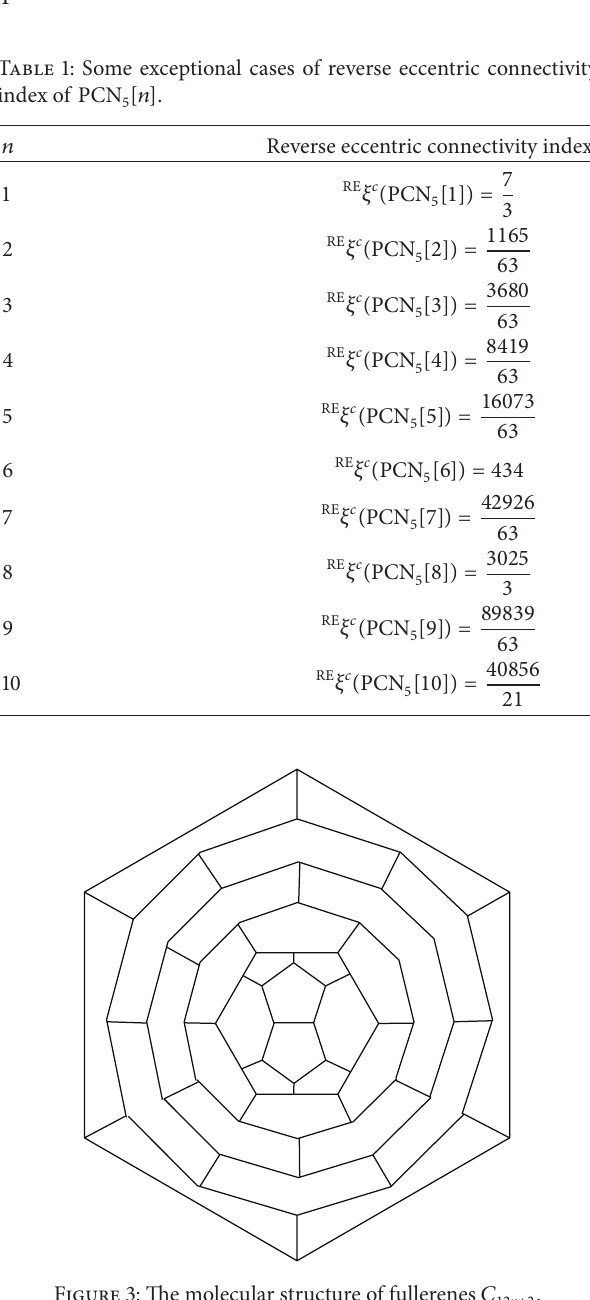
Figure 3: The molecular structure of fullerenes 𝐶 12𝑛+2 .